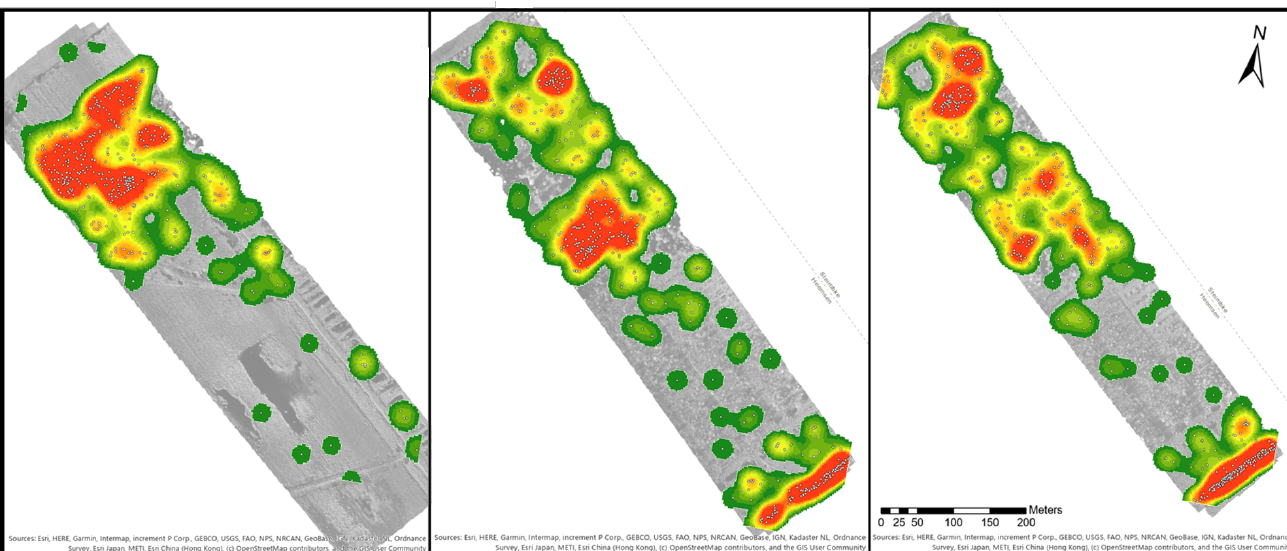
Figure 6. Density map for the blueberry species for the sites B1 to B3 (location see Figure 1). Areas of low densities are marked in green and high densities are red coloured. A gradient between green and red represents values of medium density. White points mark the location of the blueberry